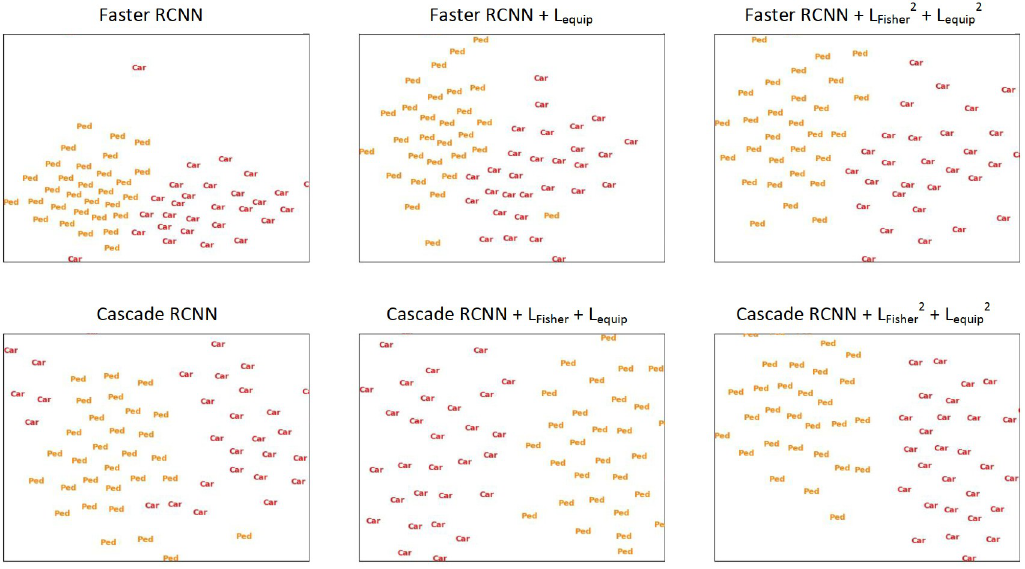
Fig 3. t-SNE visualization of Car and Pedestrian ( Ped ) instance distributions in feature spaces of object detection networks with and without structural constraints applied.